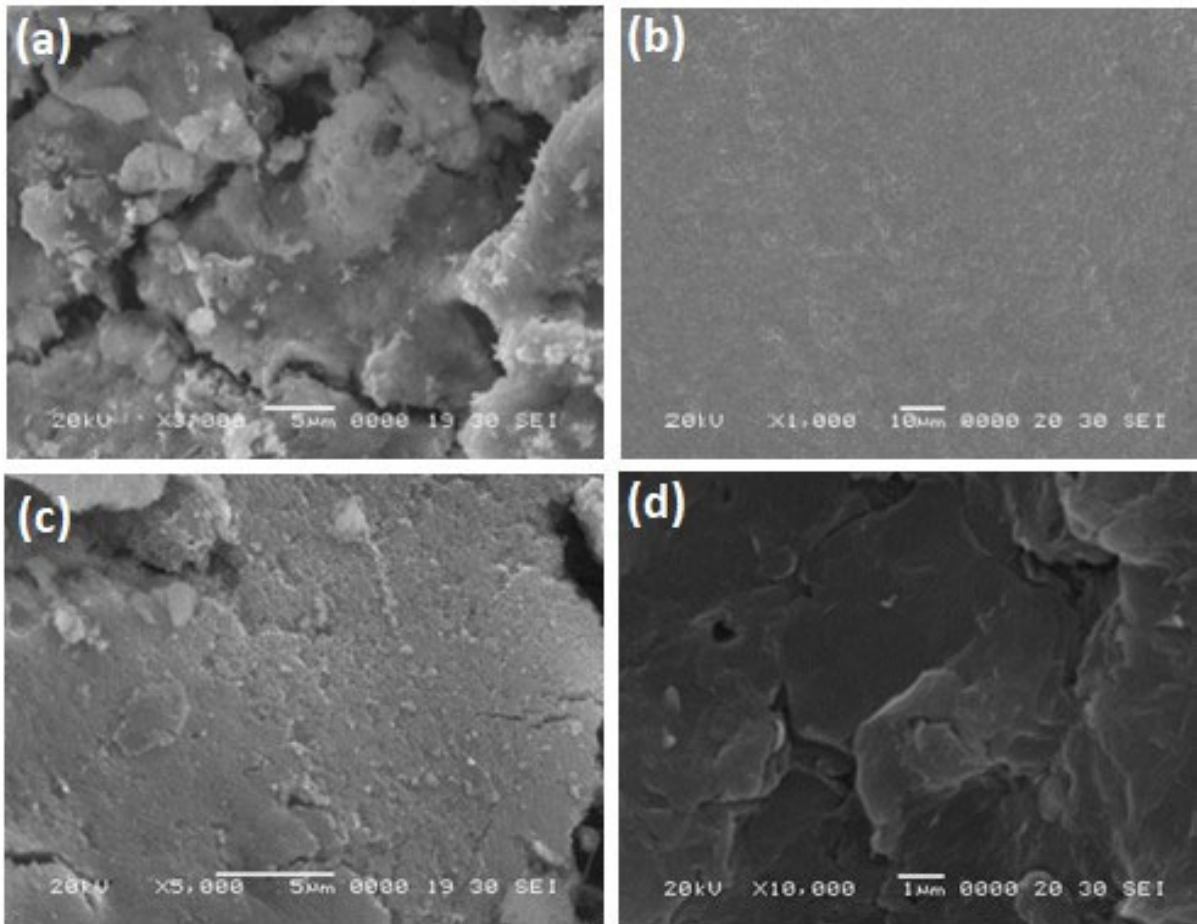
Figure 2. FESEM images of ( a ) bare GO and ( b – d ) FG after CVD treatment with different magnifi ‐ cation.